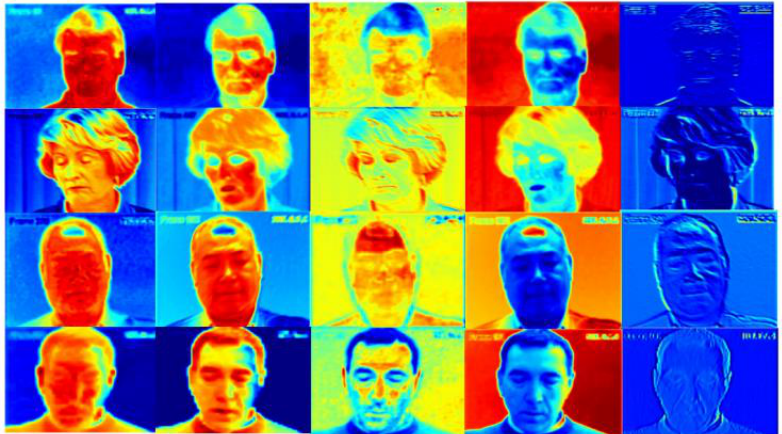
Figure 4. Heatmap for the channels with decreasing weights in the CA module. The change in color from warm to cold (e.g., red to blue) represents the reduction in attention received during training. We determined the selection of filtering channels based on the quartile rule. The mathematical language represents the output of the weight by the CA module regarding the channel-by-channel weights, where c i represents the weight of the i − th channel. Then, according to the weight size of the ascending sort, we get C (cid:48) = the quartile rule, the position of the first quartile Q1 was calculated in Equation (2), where n represents the number of weights or the number of channels. Then, we can determine the weights of all values from zero to the top 25%. The channel corresponding to the first 25% weight is masked, which is the filter channel we selected (Equation (3)).